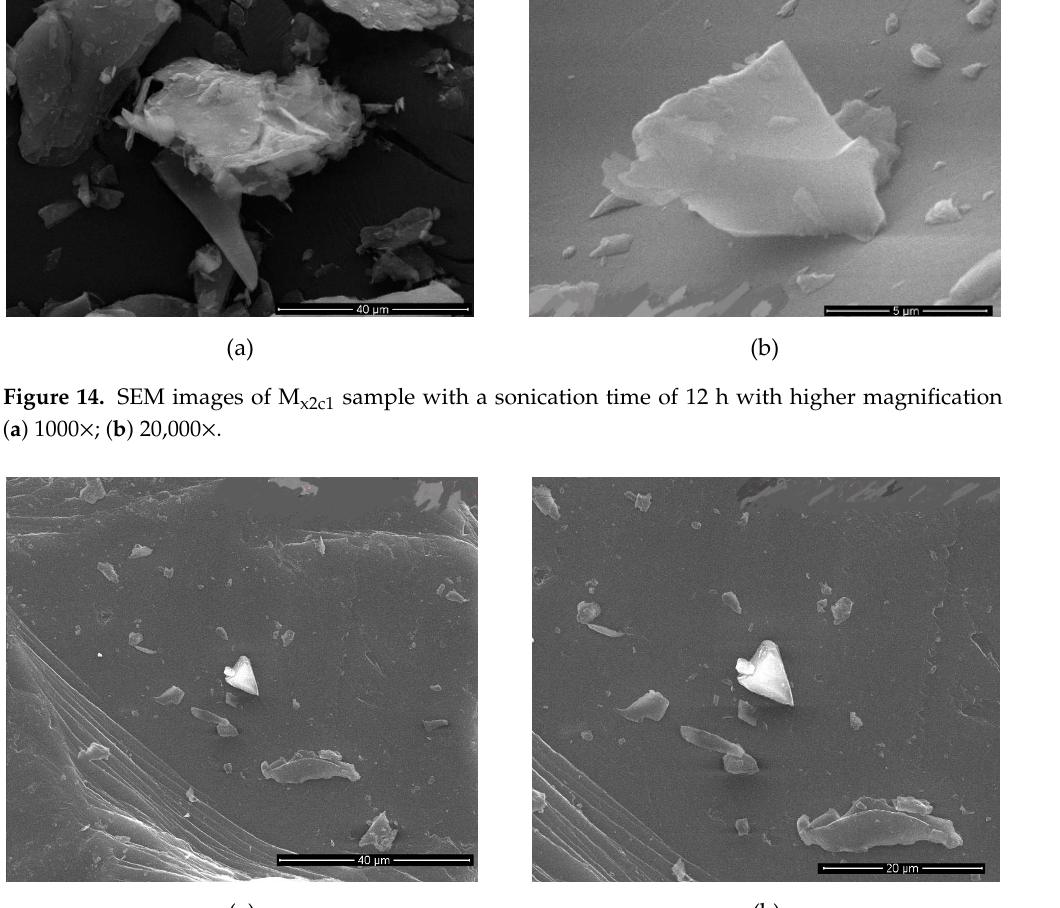
Figure 15. SEM images of M x3c3 sample with a sonication time of 9 h with higher magnification ( a ) 3000×; ( b ) 5000×.